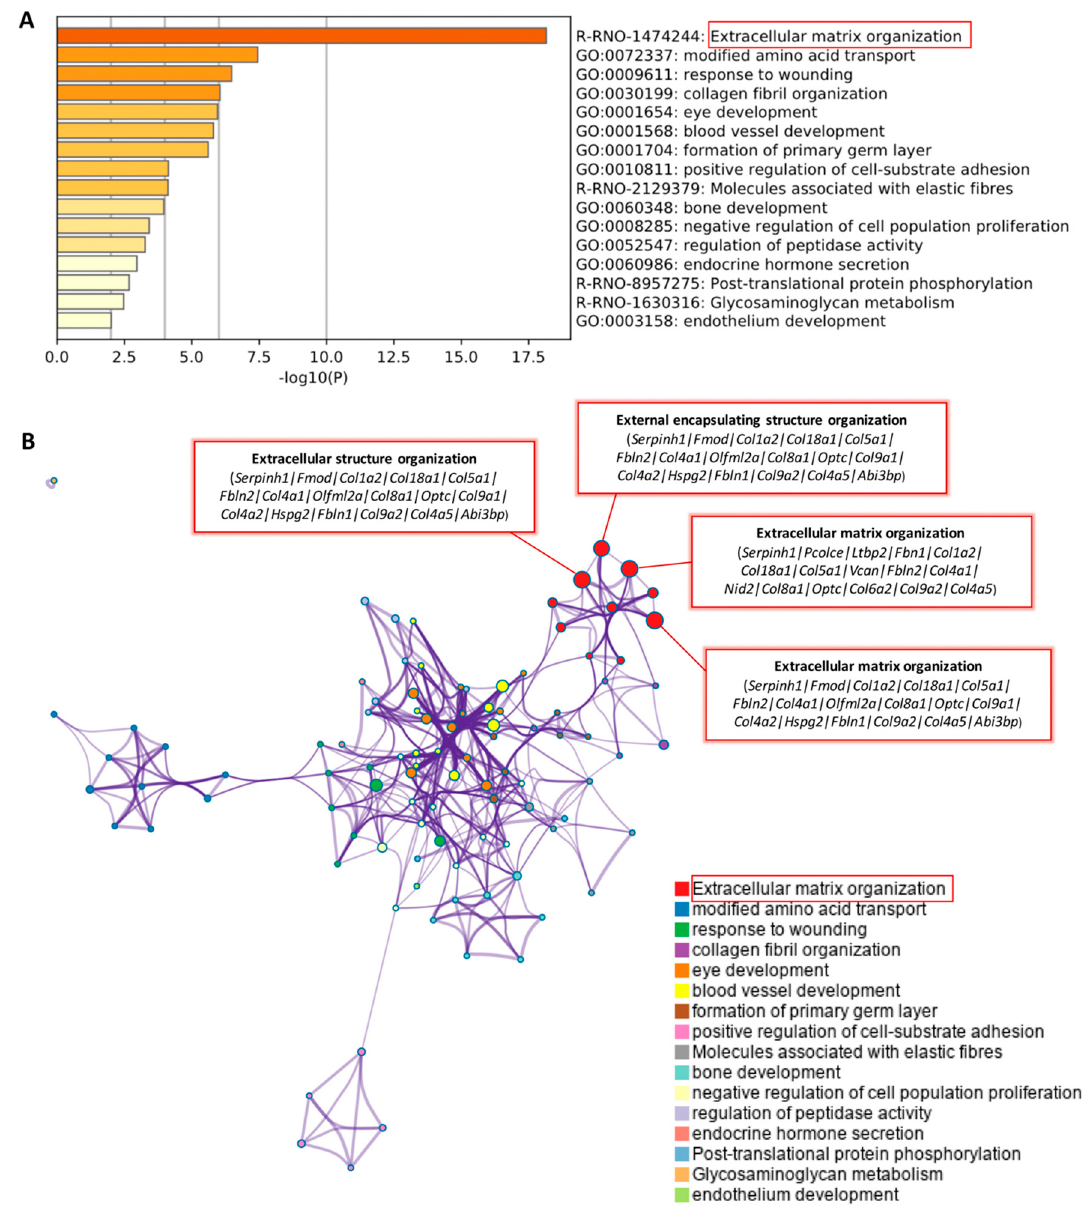
Figure 3. The enrichment analysis of 55 significant up-regulated genes was performed by Metascape. ( A ) Metascape bar graph for viewing the top enriched clusters, where each cluster uses a discrete color to indicate statistical significance. ( B ) Metascape visualization of the interactome network formed by all 55 genes from the Table 1, where the MCODE compounds are colored according to their identities. The most interesting enriched terms in the category were extracellular matrix organization (red box).